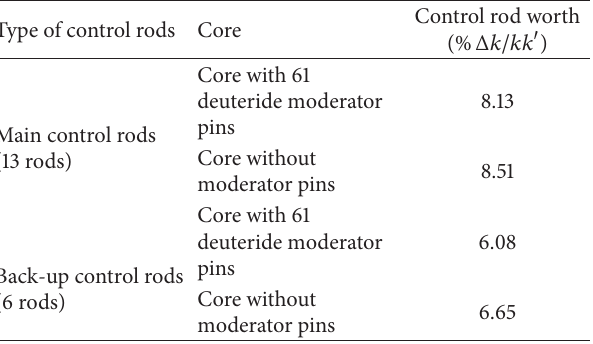
Table 7: Comparison of control rod worth between cores with and without moderator.